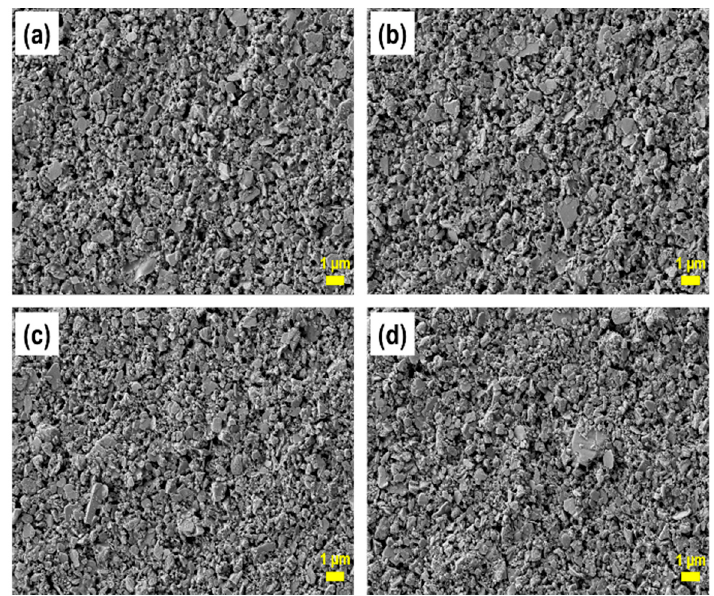
Figure 5. Field-emission scanning electron microscopy images of coating layers containing various amounts of PS latex: ( a ) 0 parts per hundred (pph), ( b ) 1 pph, ( c ) 3 pph, and ( d ) 5 pph.